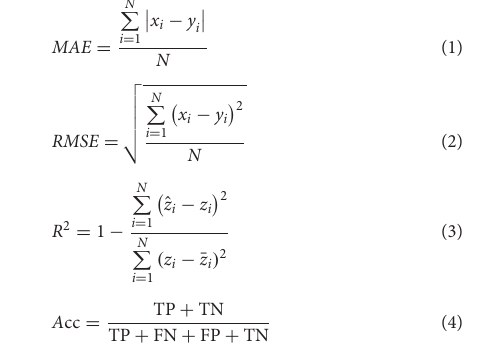
TABLE 2 | Music recognition rate of various feature combinations based on BP algorithm.